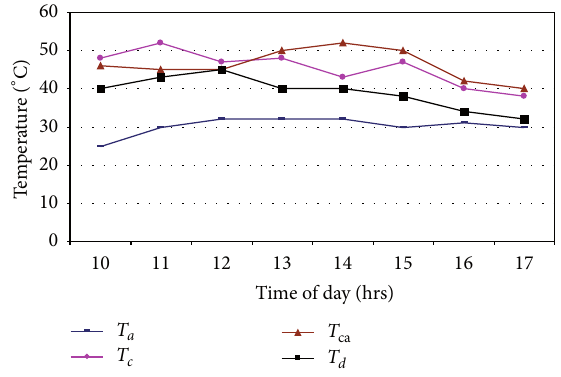
Figure 2: Ambient, collector, collector case, and food cabinet temperatures for Day 1.